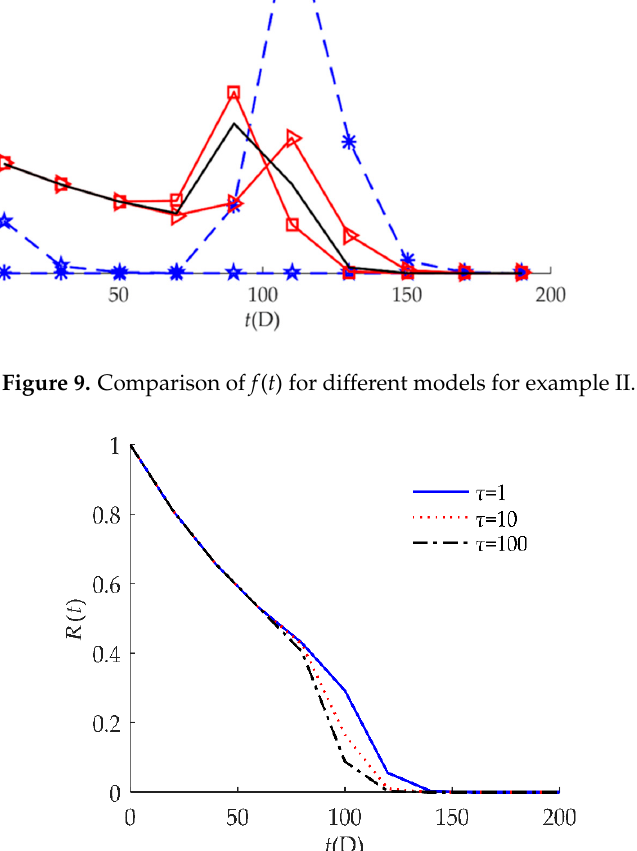
Figure 10. Sensitivity analysis of R ( t ) on τ for example II.